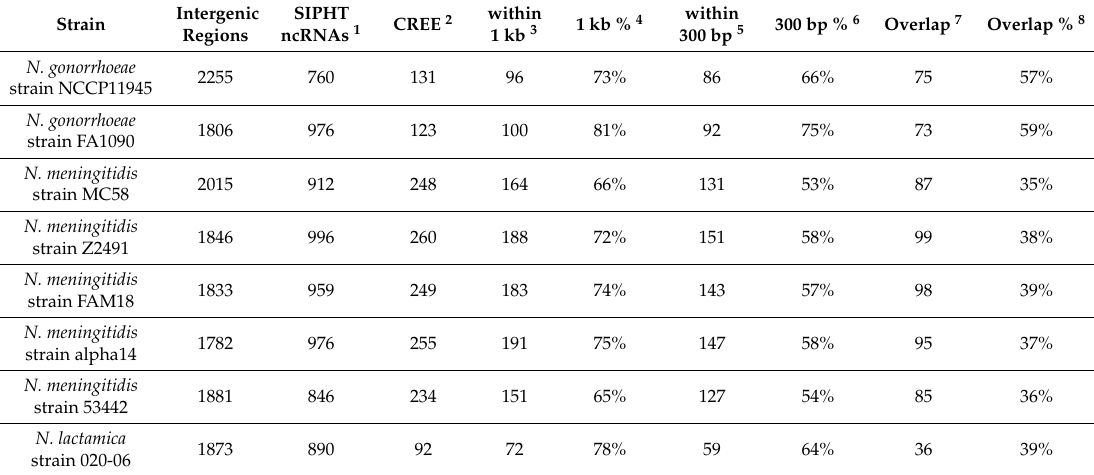
Table 3. Correia Repeat Enclosed Elements (CREE) associations with ncRNAs in Neisseria spp. genome